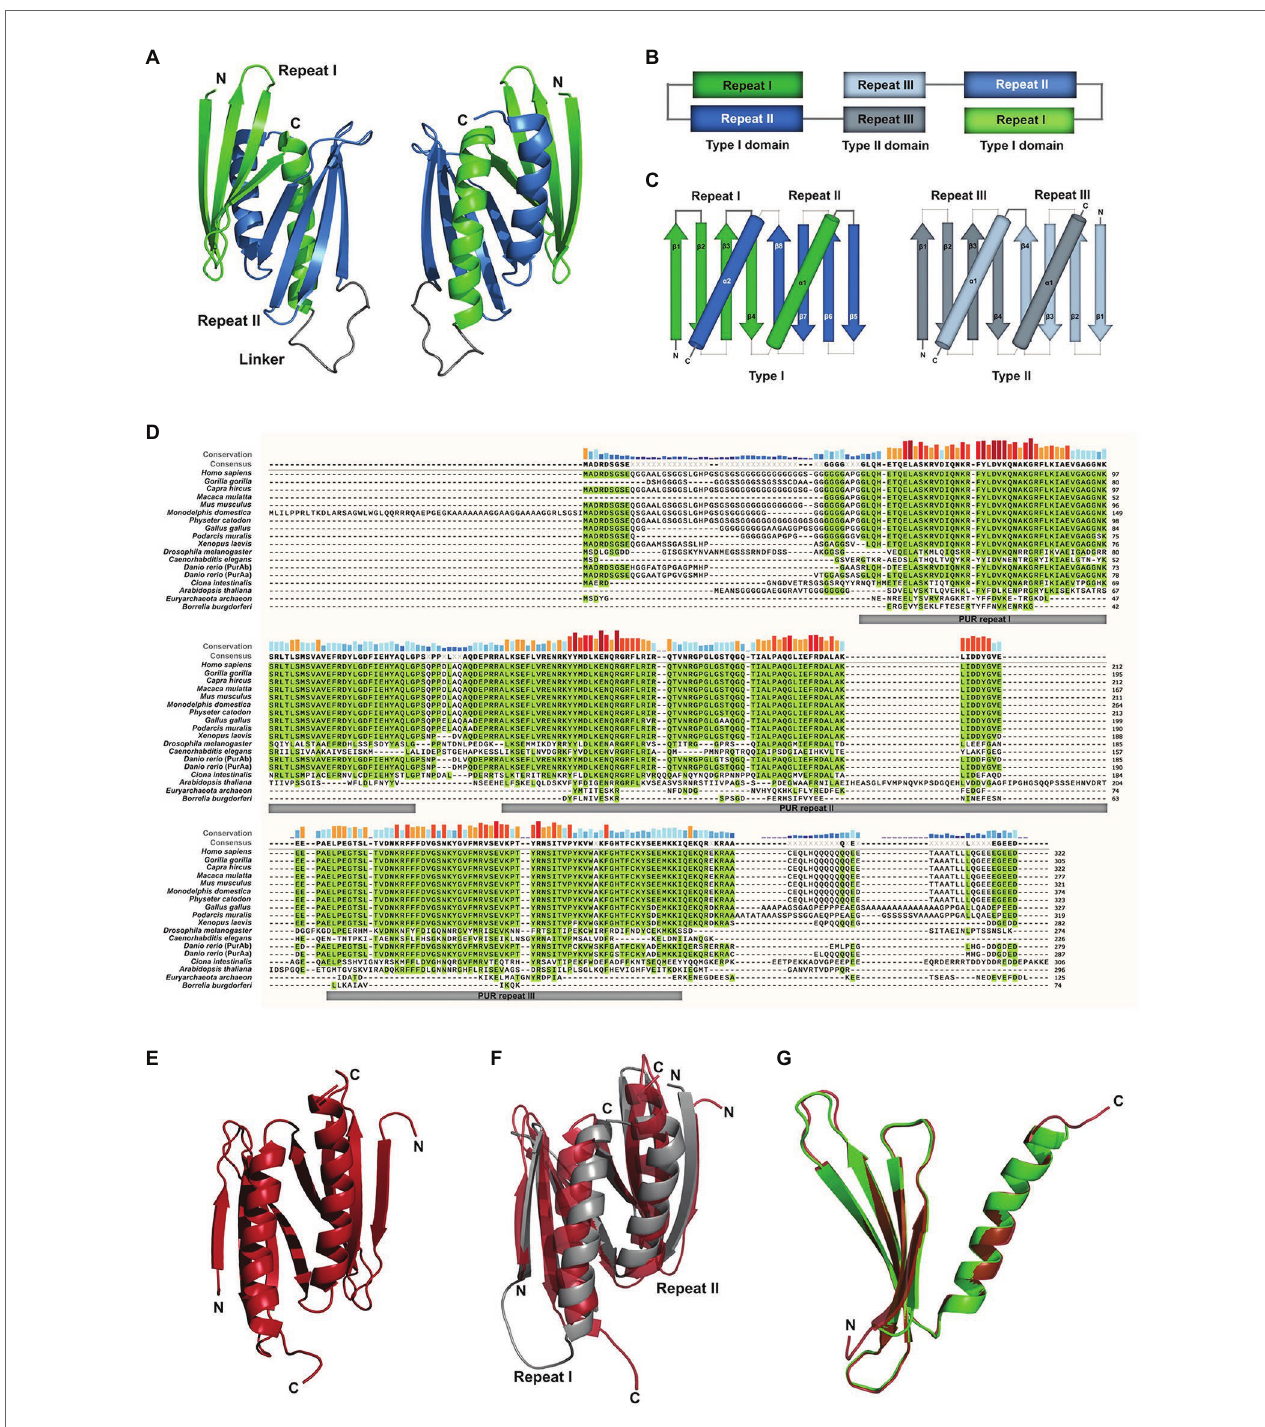
FIGURE 1 | Assessment of structural and sequence conservation between PURA proteins from different species. (A) Cartoon backbone model of the PURA DNA-binding domain of Drosophila melanogaster and a view rotated 180 ° . (B) Schematic illustration of the domain organization of the PURA homodimer. (C) Topology diagram of the type I and type II domain of PURA. (D) Amino acid sequence alignment of PURA from selected species with identical amino acids highlighted in green. The sequence similarity is notably higher within the PUR repeats and decreases with evolutionary distance. The alignment was executed using the MUSCLE algorithm and program MEGAX (Hall, 2013; Mello, 2018). (E) Cartoon backbone model of Borrelia burgdorferi PURA domain forming a type II homodimer (C) . (F) Superposition of the DNA binding domain of D. melanogaster [shown in (A) ] and B. burgdorferi [shown in (E) ; RMSD = 2.107]. (G) Superposition of D. melanogaster PURA repeat I and B. burgdorferi PURA (RMSD =